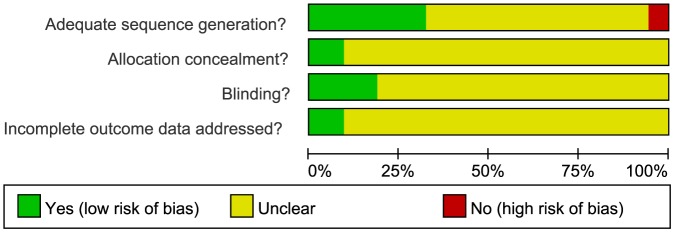
Methodological quality graph summarizing the risk of bias from all included studies.